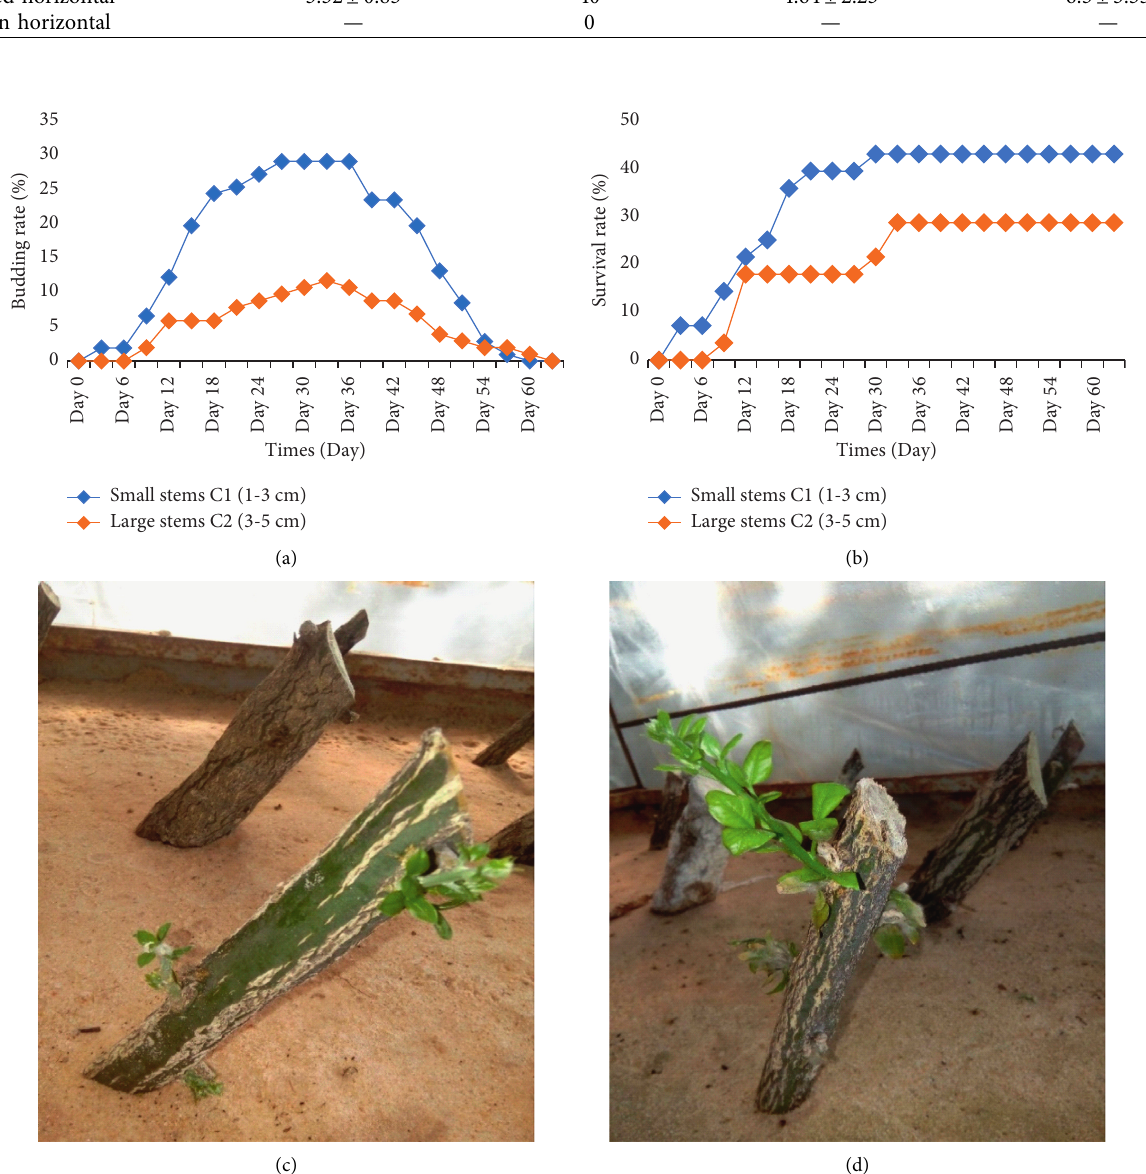
Figure 6: Parameters for stem cutting segments of Balanites aegyptiaca at the Regional Centre for Agricultural Research (CERRA), Maradi, Niger. Variation in budding rate (a), variation in the recovery rate (b), budded (c), and resumed cuttings